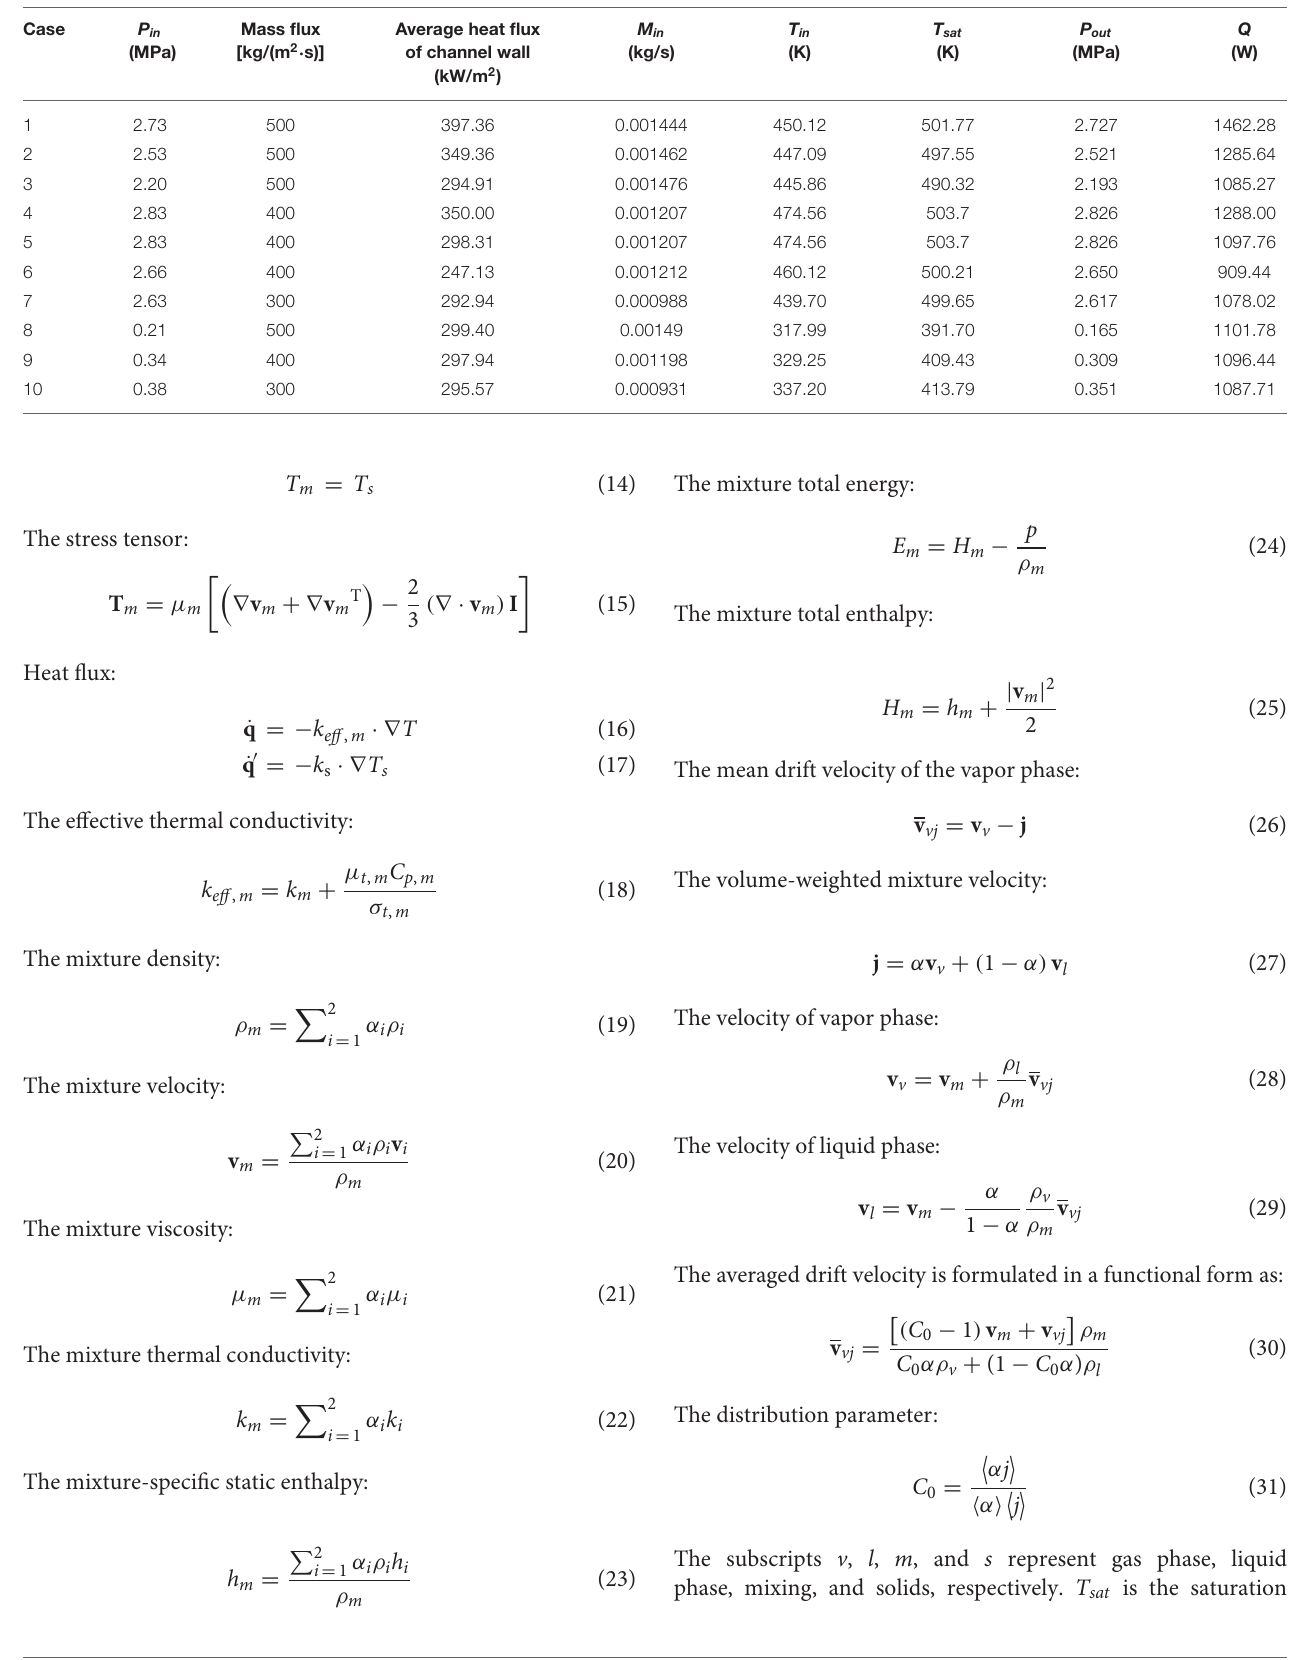
TABLE 1 | Simulation cases based on experimental